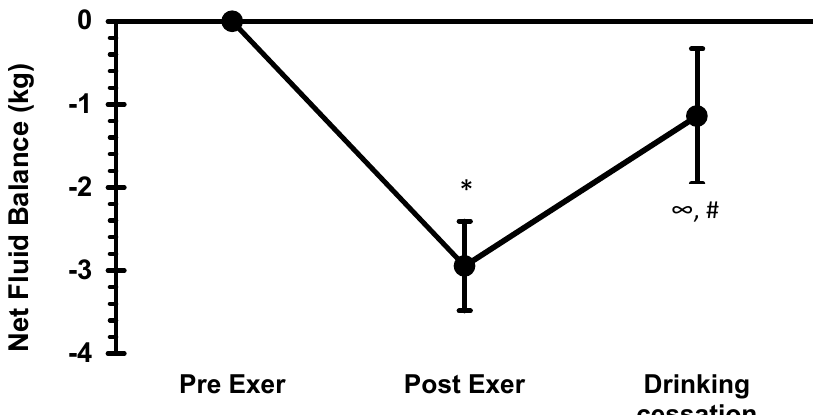
Figure 4. ANOVA analysis of thirst perception, no difference pre- vs. drinking cessation ( p = 0.289), * pre-exer vs. post-exer (dehydration) ( p < 0.0001), ∞ post-exer (dehydration) vs. drinking cessation ( p < 0.0001). Bar height represents average values; dots represent individual thirst perception. Net fluid balance (Figure 5) ANOVA (F = 57.97, p < 0 .0001) shows statistically signif- icant differences among measures of pre- (0 ± 0) and post-exercise ( − 2.94 ± 0.57; p < 0 .0001), post-exercise and drinking cessation (1.14 ± 0.86; p < 0 .0001), and pre-exercise and drinking cessation ( p = 0.0012).